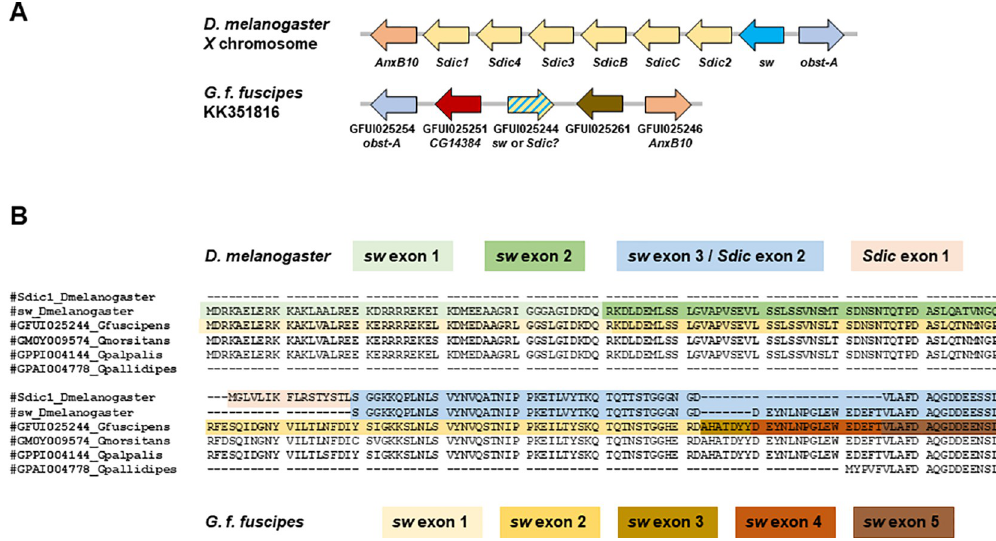
Fig 1. The ortholog to the G . f . fuscipes gene GFUI025244 in D . melanogaster is sw and not Sdic . (A) Gene organization surrounding Sdic and sw in D. melanogaster according to the annotation of the Berlin genome assembly for the reference strain ISO-1 [5]compared to that around the gene GFUI025244 in the supercontig KK351816 of the G . f . fuscipes genome assembly 3.0.2 (GenBank accession: GCA_000671735.1). For G . f . fuscipes , the name of the presumed ortholog in D . melanogaster is also provided. Gene size and spacing are not to scale. Based on the current assembly of the region, only one of the two genes, Sdic or sw , is present in G . f . fuscipes . (B) Sequence alignment of the D . melanogaster proteins Sdic and sw, and the protein predicted by VectorBase to correspond to Sdic in G . f . fuscipes and three close relatives. Only the first 200 amino acids from the N-terminus are shown. As a Sdic protein of D . melanogaster ,only the product encoded by the paralog Sdic1 in the reference strain ISO-1 is included in the alignment; all encoded proteins by D . melanogaster Sdic paralogs have an identical 5’ termini [5].The amino acid sequence encoded by different exons of the genes sw and Sdic in D . melanogaster and G . f . fuscipes are color coded. The gene ID in each Glossina species is indicated before the species name. The presumed Sdic protein in a fourth species, G . austeni , was omitted as it is fragmented into three partial ORFs. As shown in the alignment, the encoded protein by GFUI025244 exhibits high sequence identity with the entire sw protein of D . melanogaster ,which is not the case in relation to the Sdic1 protein as it is defective for the residues coded by the first two exons of sw